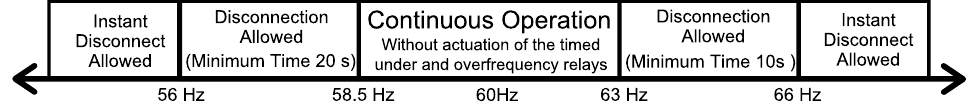
Figure A1. Nonrated frequency regime for wind and solar generating units [38].